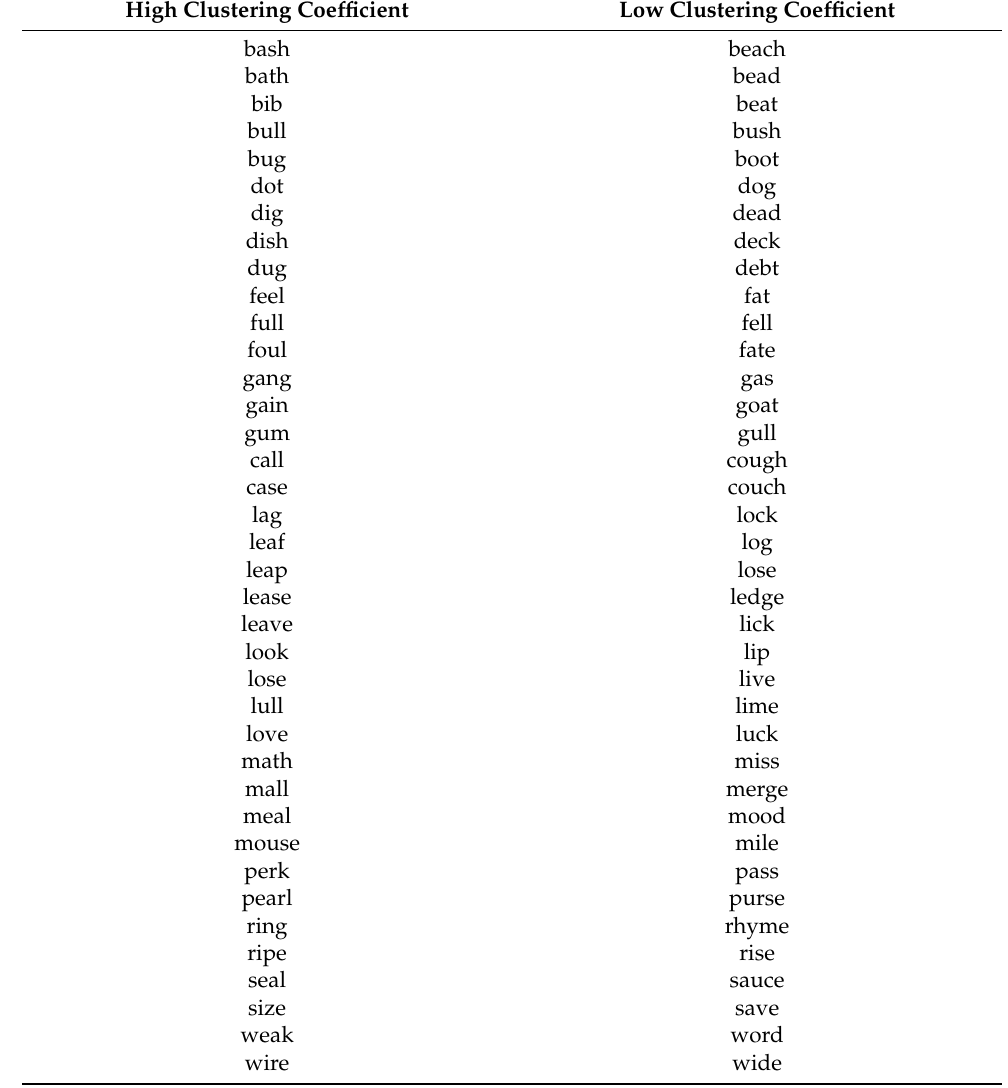
Table A1. Stimulus words from Chan and Vitevitch (2009) that were used in Simulation 1. High Clustering